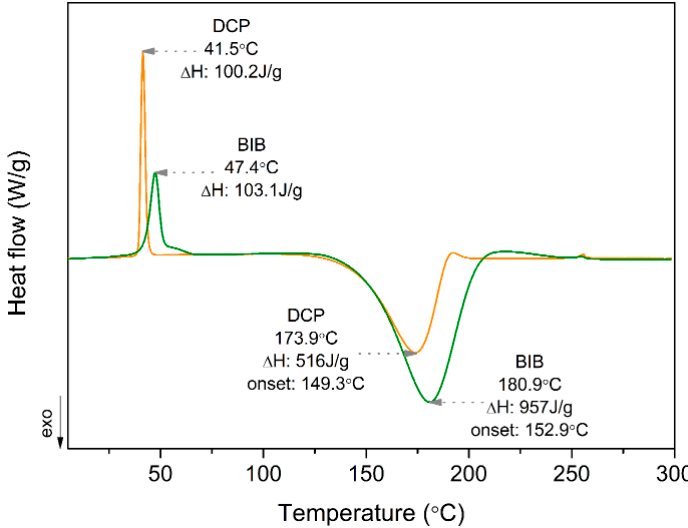
Figure 1. Heat flow vs. temperature for thermal decomposition of DCP and BIB peroxides.